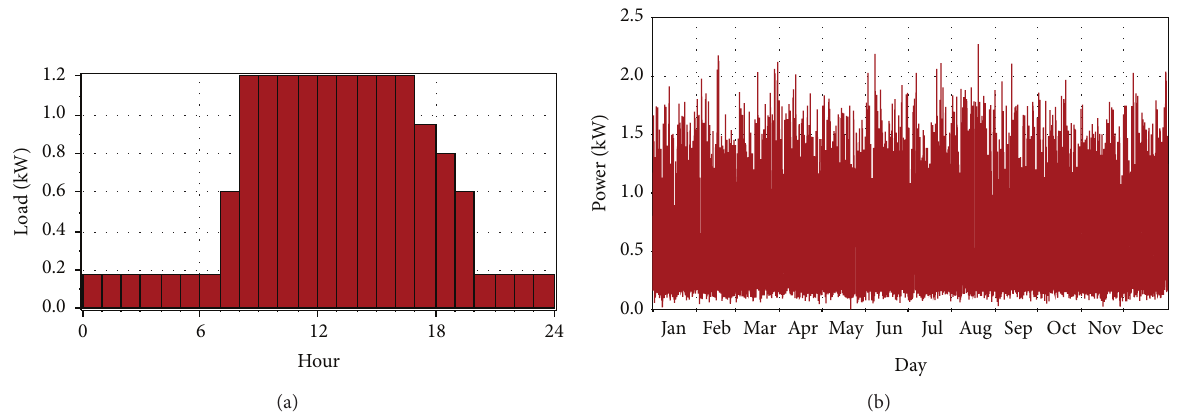
Figure 10: Thermal load. (a) Daily profile. (b) Yearly profile.